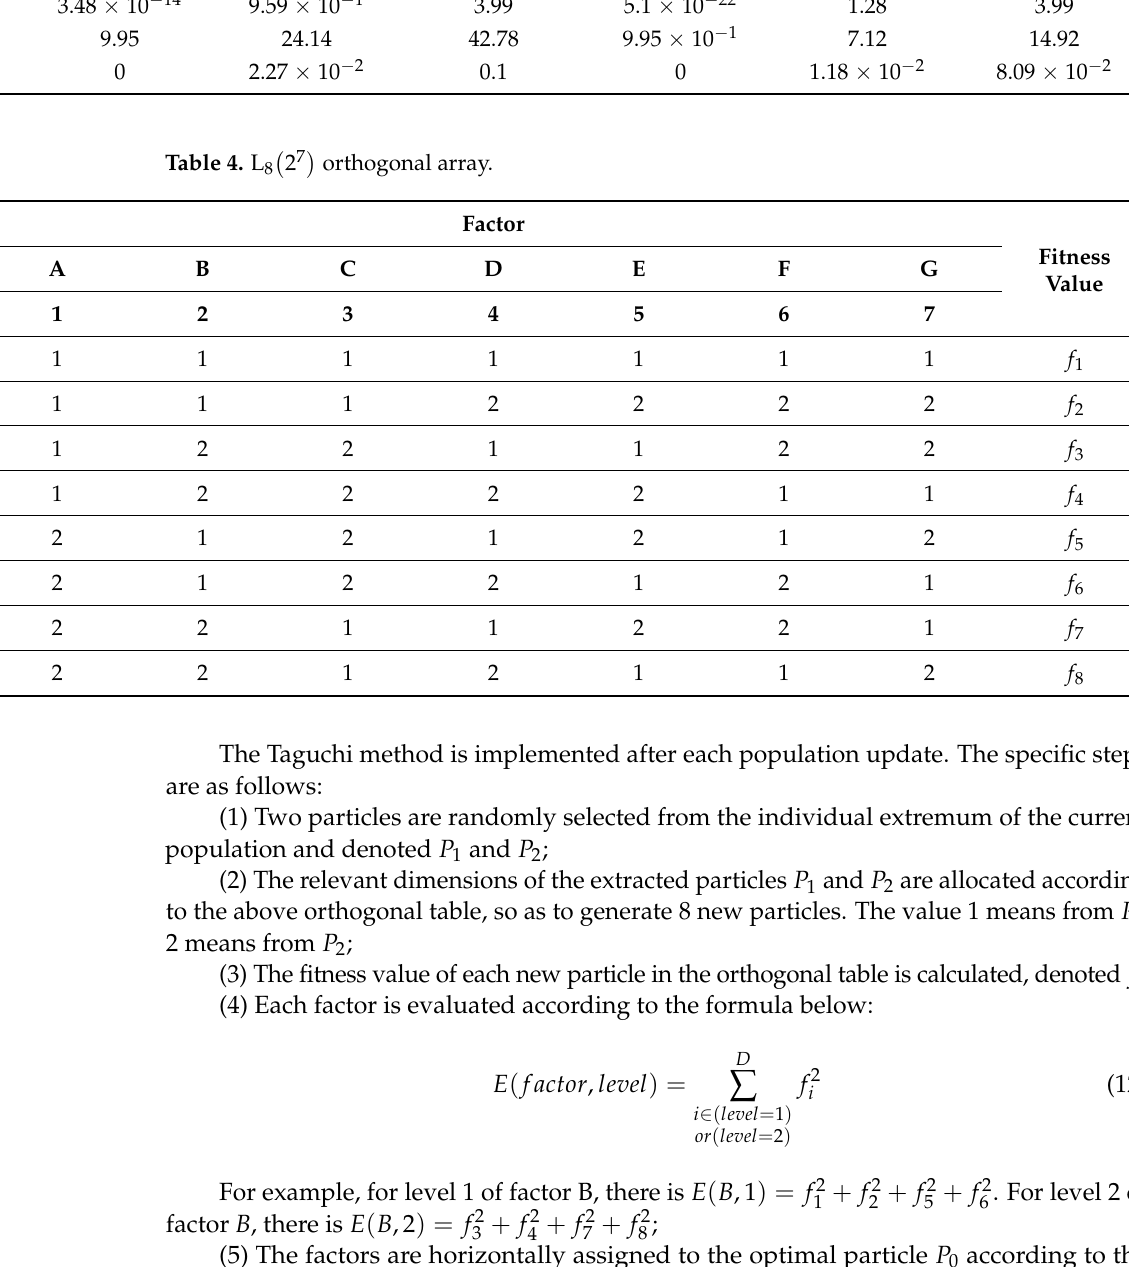
(cid:0) (cid:1) 2 7 orthogonal